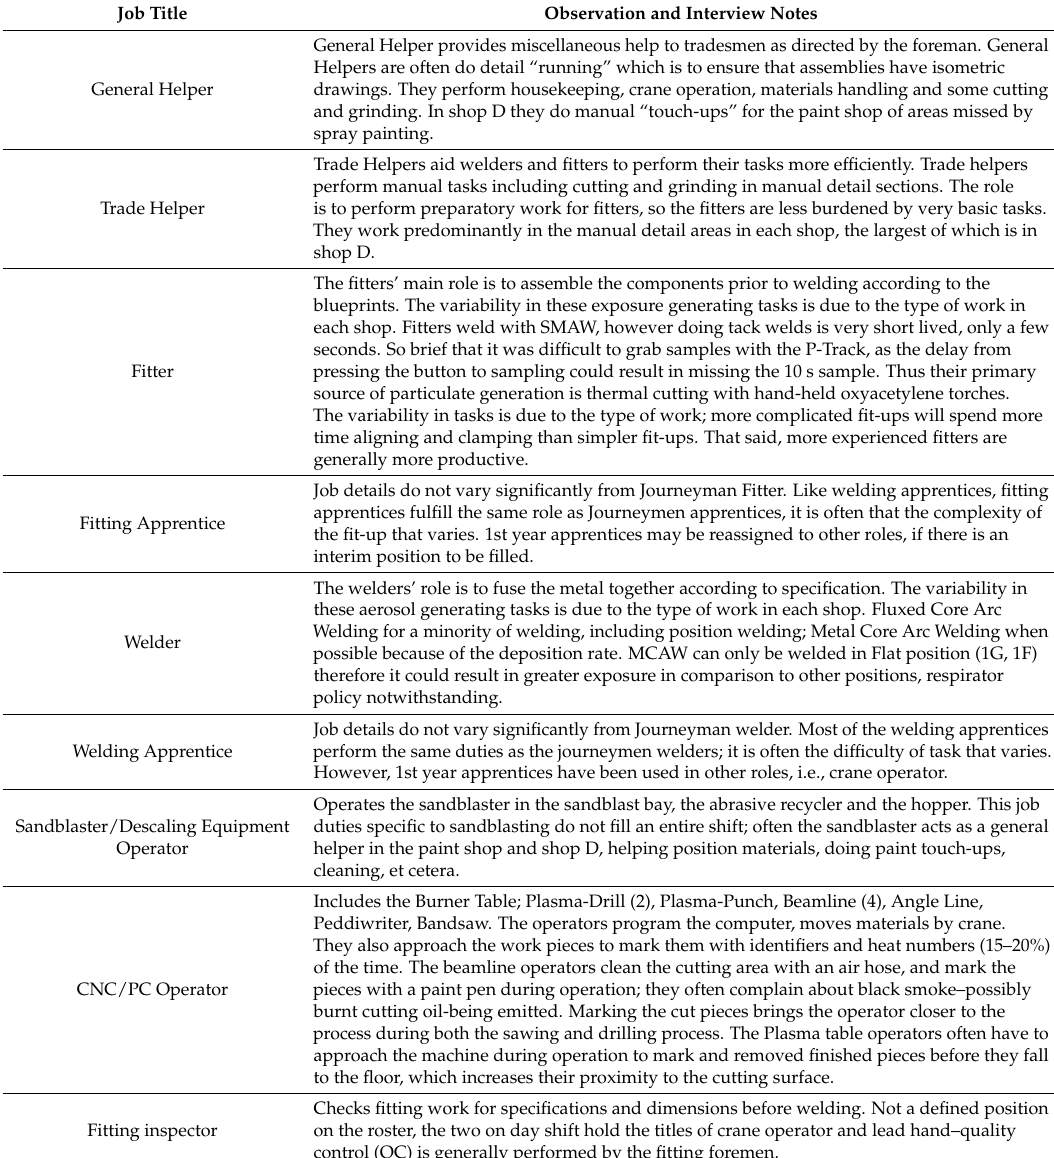
Table A1. Detailed information about job titles, field observations and interview